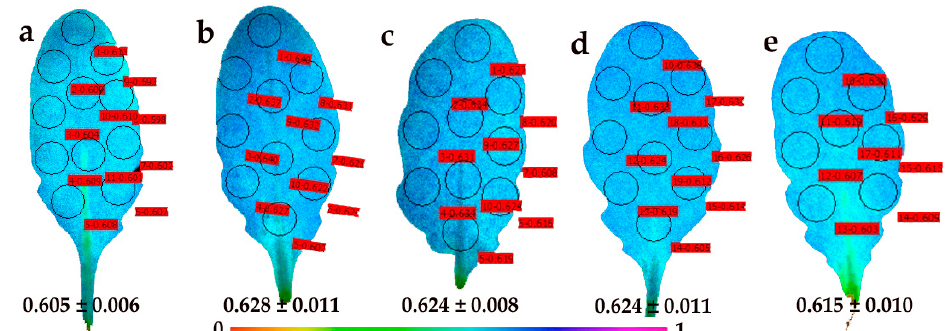
Figure 8. Representative chlorophyll fluorescence images of the effective quantum yield of PSII photochemistry ( Φ PSII ) of Arabidopsis thaliana mature leaves after 5 min of illumination at 140 µ mol photons m − 2 s –1 . Leaves were measured after the foliar spray with distilled water (control) ( a ), or 30 min ( b ), 90 min ( c ), 180 min ( d ) and 240 min ( e ) after the foliar spay with 30 mg L − 1 of CuZn NPs. The color code depicted at the bottom of the images ranges from values 0.0 to 1.0. The areas of interest (AOI) are shown in each image. The average Φ PSII value of all the AOI for the whole leaf is shown.